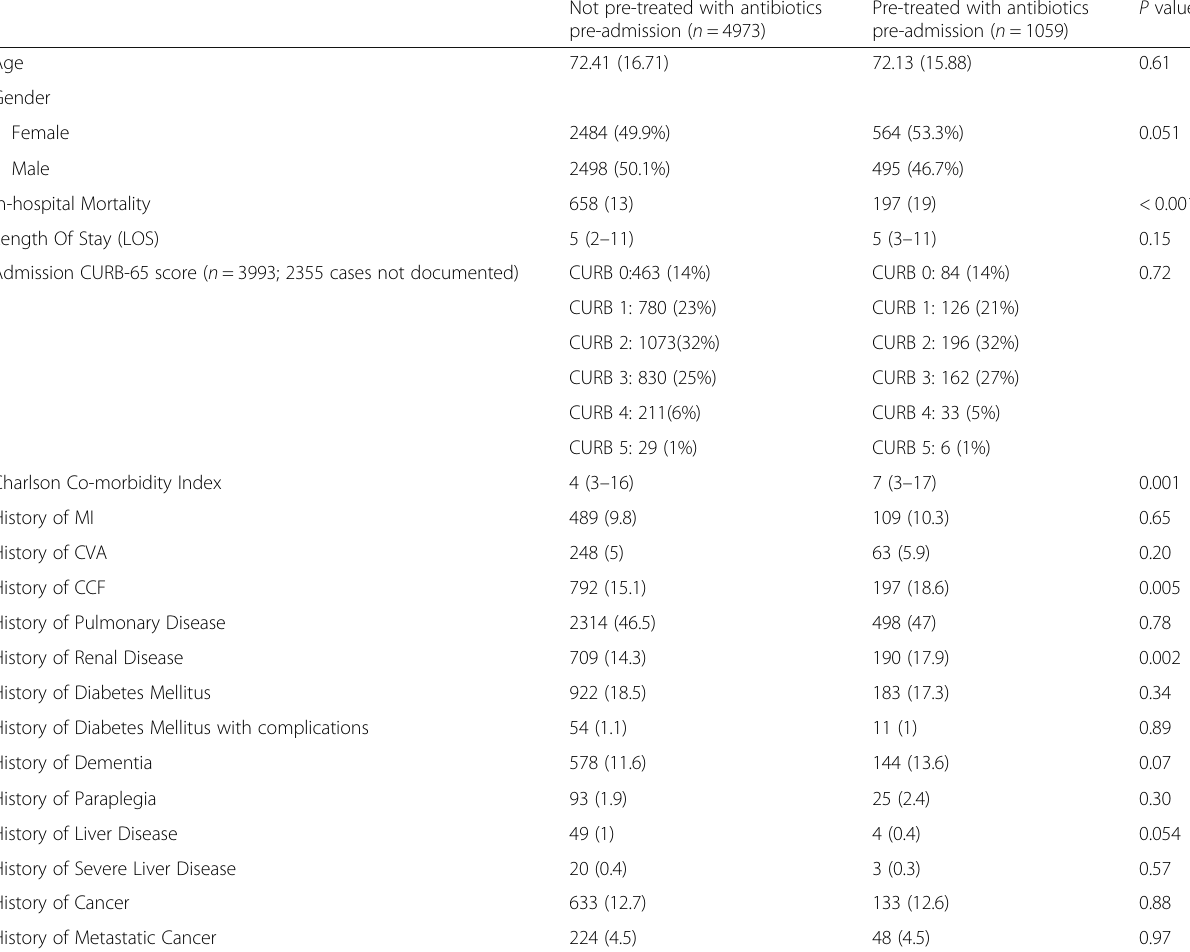
Table 3 Comparison of subjects “ pre-treated ” with antibiotics prior to admission against those not “ pre-treated ”